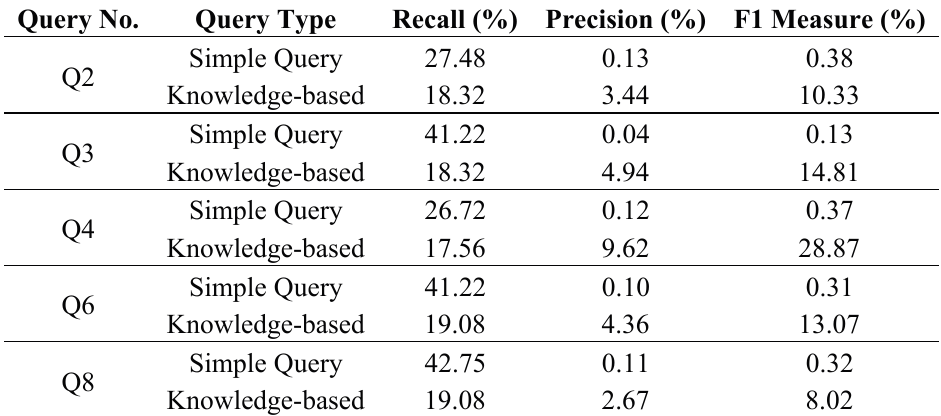
Table 4. Recall, precision, and F1 measure for knowledge-based queries in comparison to simple